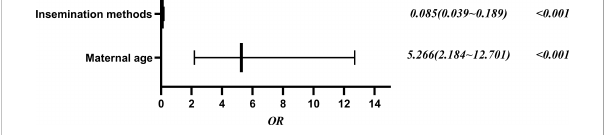
FIGURE 2 Risk factors of DCTA in the fresh ET cycle forest plot, OR (95% con fi dence interval) and P values.